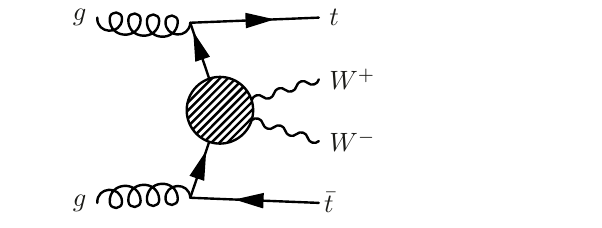
Figure 21. Schematic Feynman diagram for the EW-induced t (cid:22) tW + W of the t W t W !